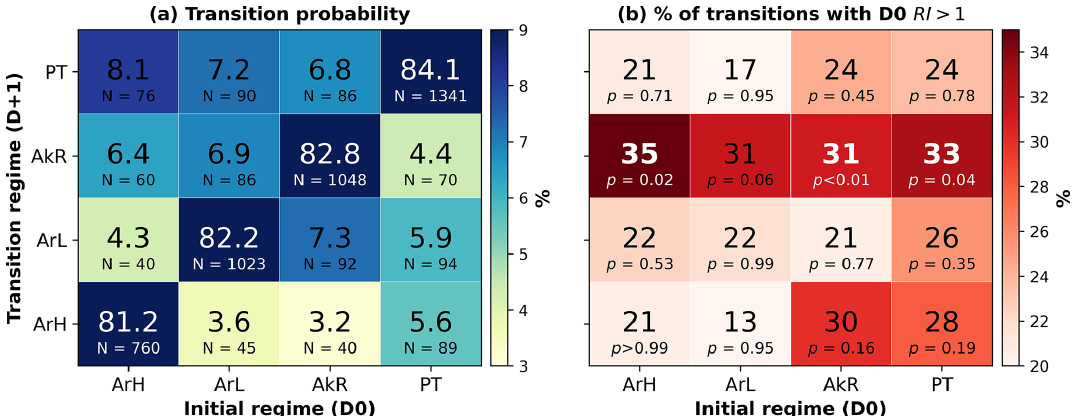
Figure 9. (a) Transition matrix for the four North American weather regimes. For each initial regime ( x axis), the numbers in each column denote the observed probability (expressed as a percentage; columns sum to 100) of persisting in the same regime (white font) or transitioning into a different regime. The total number of instances of each transition ( N ) is also shown. (b) Percentage of each transition pathway which occurs with RI > 1 on the day prior to the transition (D0), expressed as percentages. P values indicate the estimated probability of obtaining a statistic greater than the observed value by chance, assessed by randomly re-sampling all DJFM days 10000 times (without replacement) using the observed sample sizes for each transition pathway. Statistics significant at the one-sided 5% significance level are in bold white font.